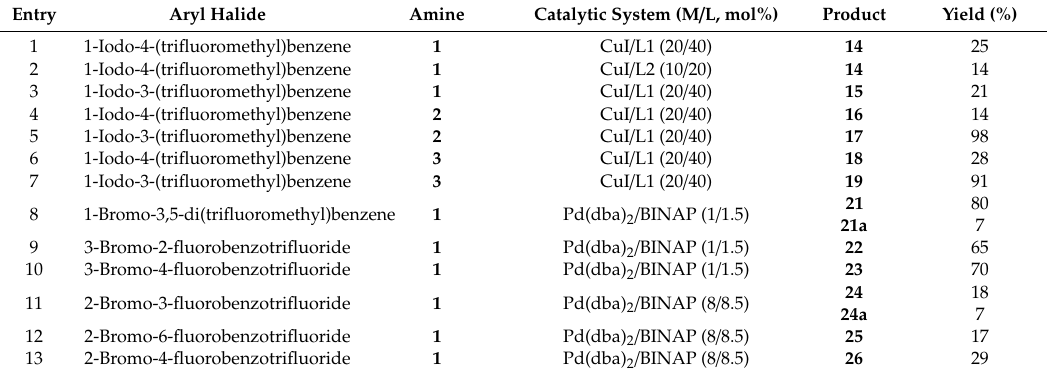
Table 2. Catalytic arylation of oxadiamines 1 – 3 with